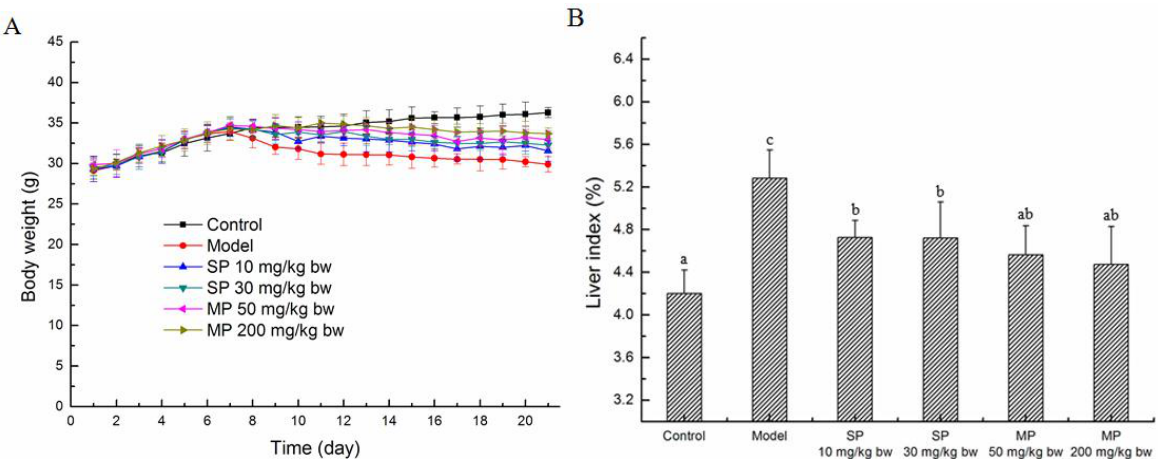
Figure 1. Body weight ( A ) and the liver index (%) ( B ) of mice in each group. Values not sharing a common letter (a, b, c) differ significantly at p < 0.05. SP, synthetic pentapeptide; MP, mixed corn